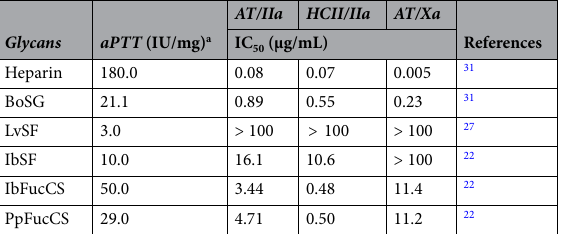
Table 2. Anticoagulant properties of heparin and MSGs. a Values calculated using a parallel of unfractionated heparin with activity of 180 IU/mg as standard